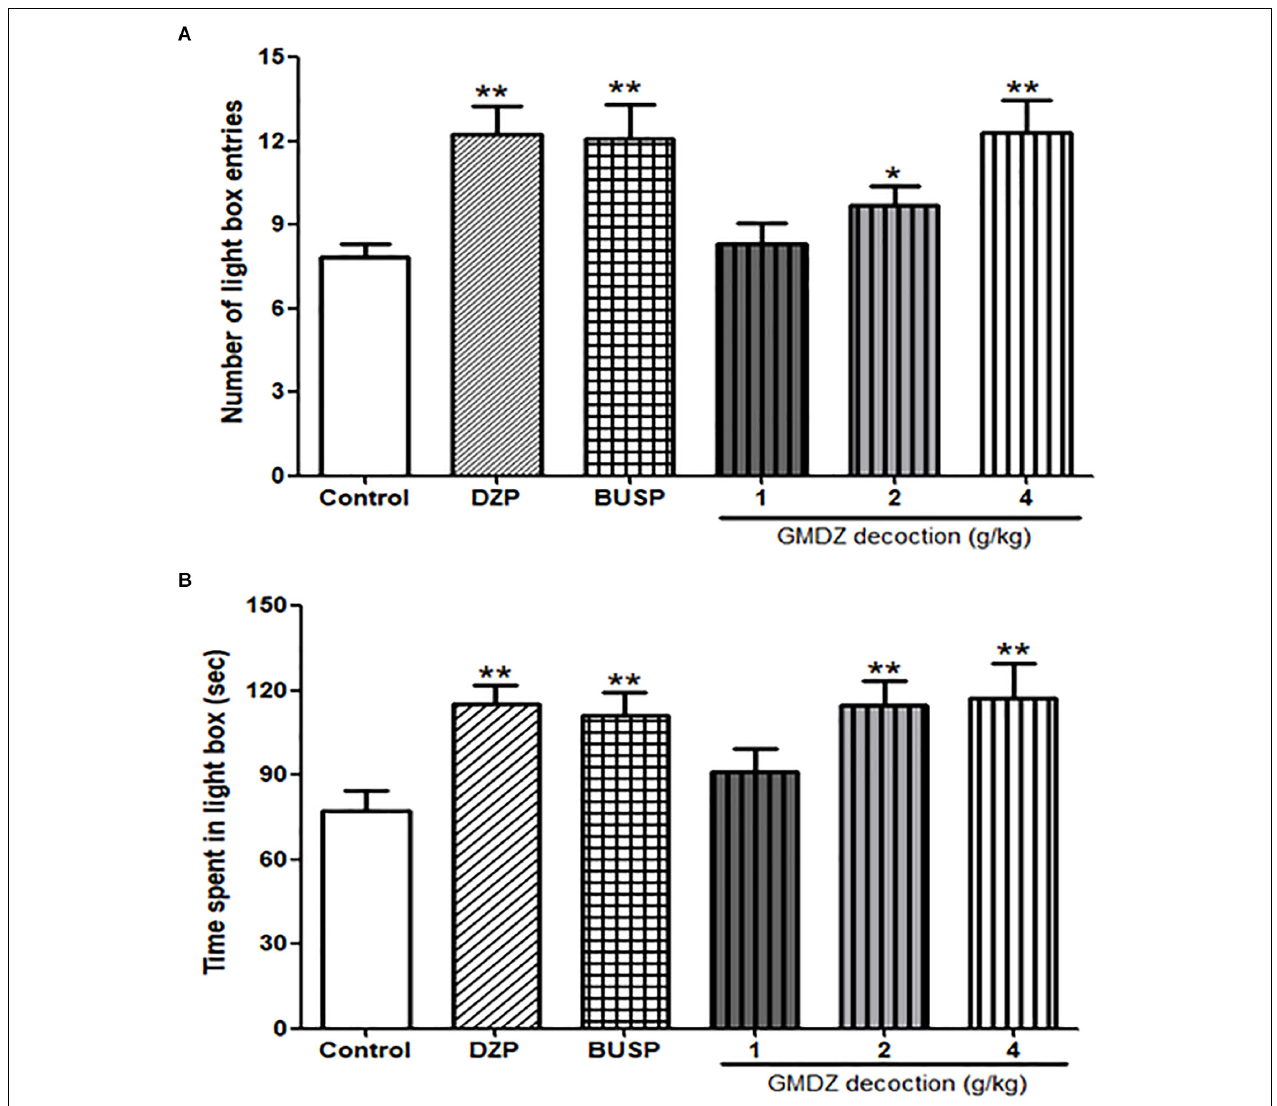
FIGURE 5 | Effect of GMDZ decoction on the LDB test. (A) The numbers of light box entries. (B) The time spent in the light box. Value are represented as mean ± SEM ( n = 12). ∗ P < 0.05 or ∗∗ P < 0.01 vs. control group. One way ANOVA with Student–Newman–Keuls post hoc